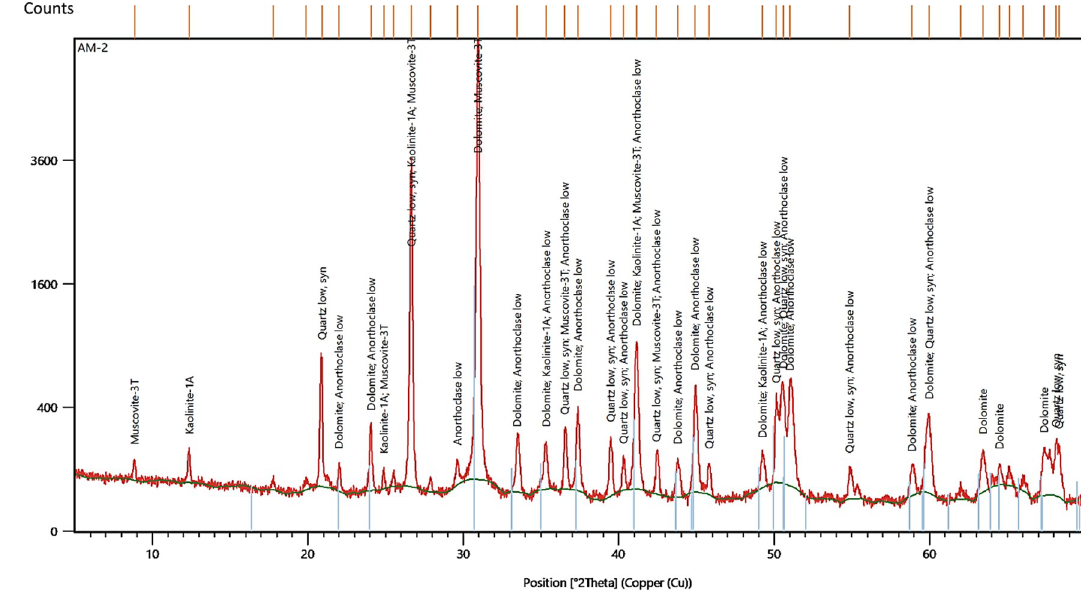
Figure A2. XRD diagram of sample Am 2 (reddish cataclasite).